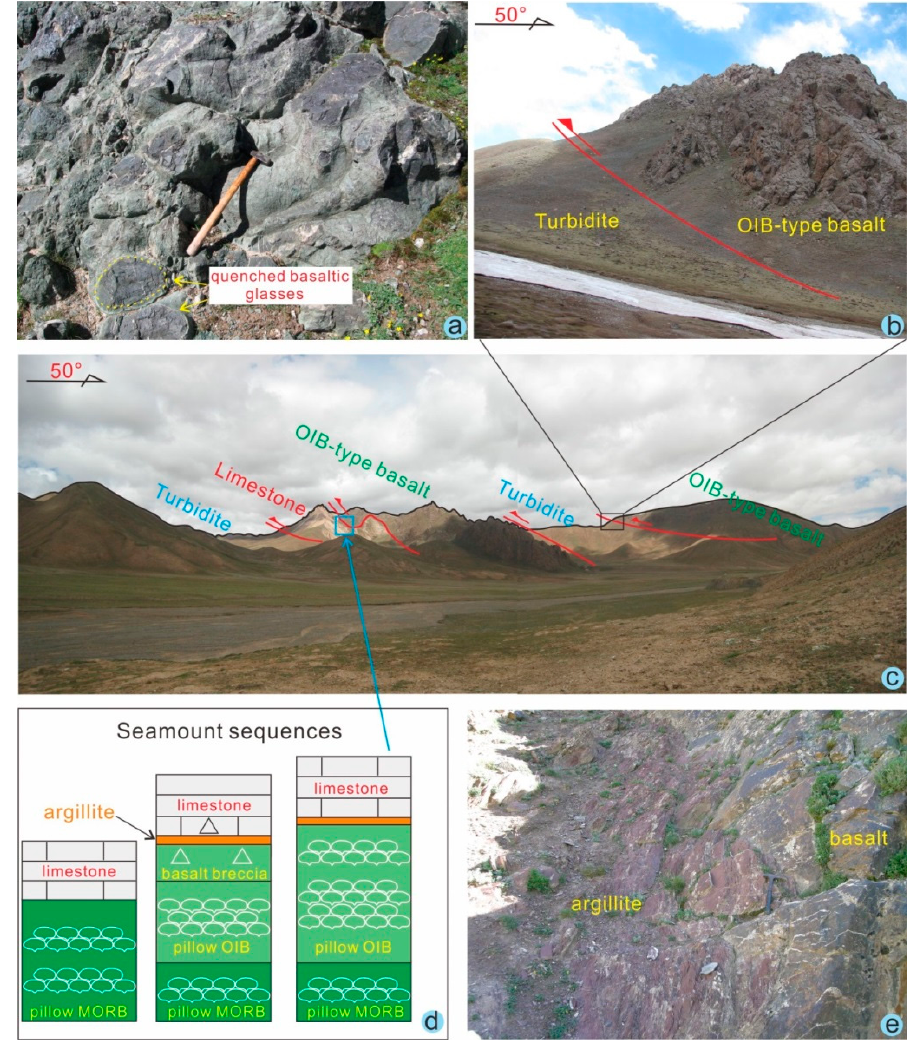
Figure 7. ( a ) Basalts exhibiting pillow structure and preserving quenched glass textures; ( b ) basalts thrust southward over strongly deformed turbidites; ( c ) paleo-seamounts preserving oceanic island basalts and a limestone cap incorporated into deformed turbidites; ( d ) seamount sequences with basaltic basement and limestone cap; ( e ) basalts within argillite-matrix m é